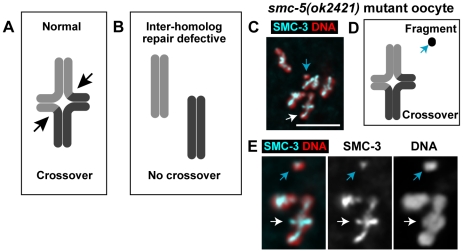
Chromosome fragmentation defects in smc-5 and smc-6 mutant diakinesis oocytes that successfully formed crossovers.Cartoon representations (A and B) of a pair of homologous chromosomes at diakinesis. (A) In wild-type, inter-homolog association is maintained by cohesion between the recombinant chromatids. The location of the chromatid exchange is indicated by the two black arrows, which provides the focal point for the restructuring of chromatid axes that results in a “cross-shape” or cruciform structure of the diakinesis chromosomes in C. elegans
[67]. (B) If inter-homolog crossover failed to form, the homologous chromosomes would prematurely separate and the chromosome axes will not have the cruciform shape. (C) Micrograph of an smc-5(ok2421) mutant oocyte containing six linked homolog pairs with the wild-type cruciform shape, indicating successful inter-homolog crossover formation. Projection depth and scale bar = 5 µm. (D) A cartoon representation of the linked homolog and DNA fragment shown in (C and E). (E) Magnified view of a linked homolog pair (white arrow) and a chromosome fragment (light blue arrow) from (C) for which cohesin SMC-3 staining also was detected on the fragment. Projection depth = 2 µm.